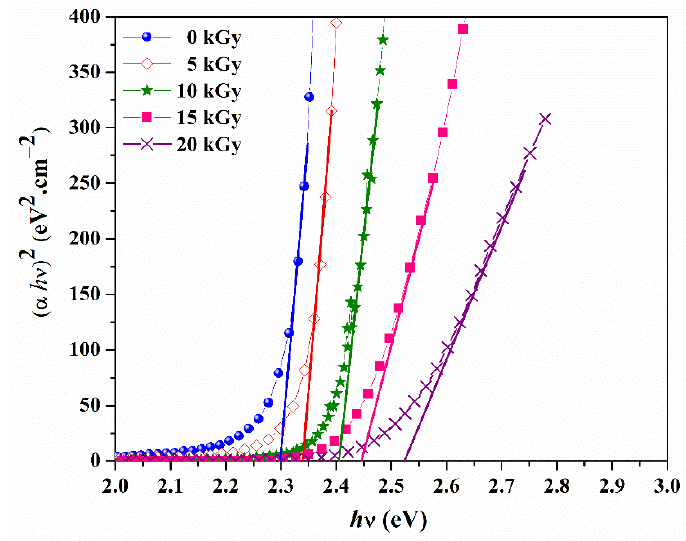
Figure 4. Photon energy ( hν ) and ( αhν ) 2 of B-co-MP in THF at a concentration of 1 µM at different gamma doses. Table 1. The variation of optical energy band-gap ( 𝐸 𝑔 ), the number of carbon atoms per conjugated length (N), and refractive index ( 𝑛 ) for B-co-MP in THF at a concentration of 1 µM at different gamma doses.